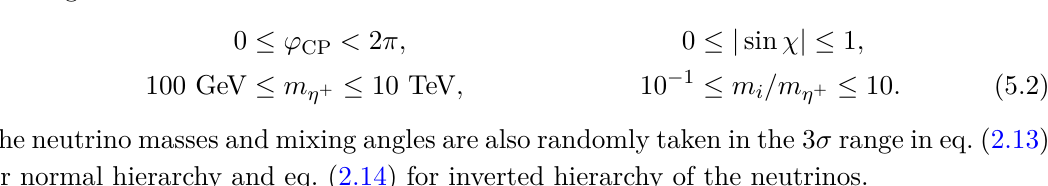
Figure 7 . Contours of the predicted electron EDM in the ( m 1 , m factors J M = 0 . 1 is assumed. The other fermion mass is fixed as m 2 = 3 m 1 in the left panels and m 2 = 1 TeV in the right panels. The gray region is excluded by the current upper bound of electron EDM given by the ACME Collaboration